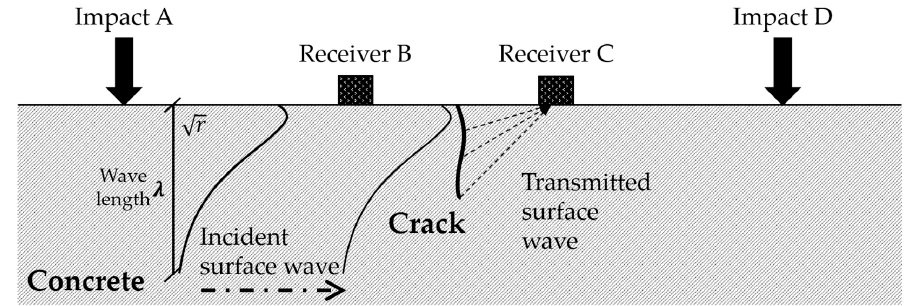
Figure 3. Transmission of surface waves across a crack.